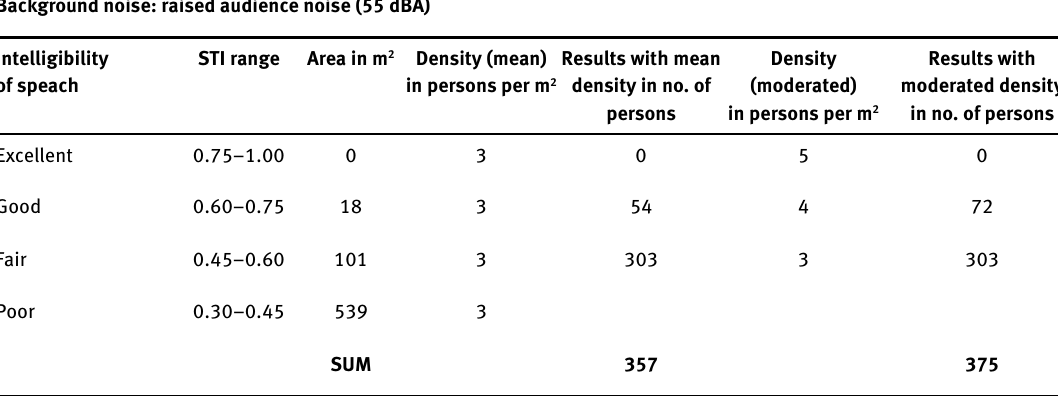
Table 4. Results for the Temple of